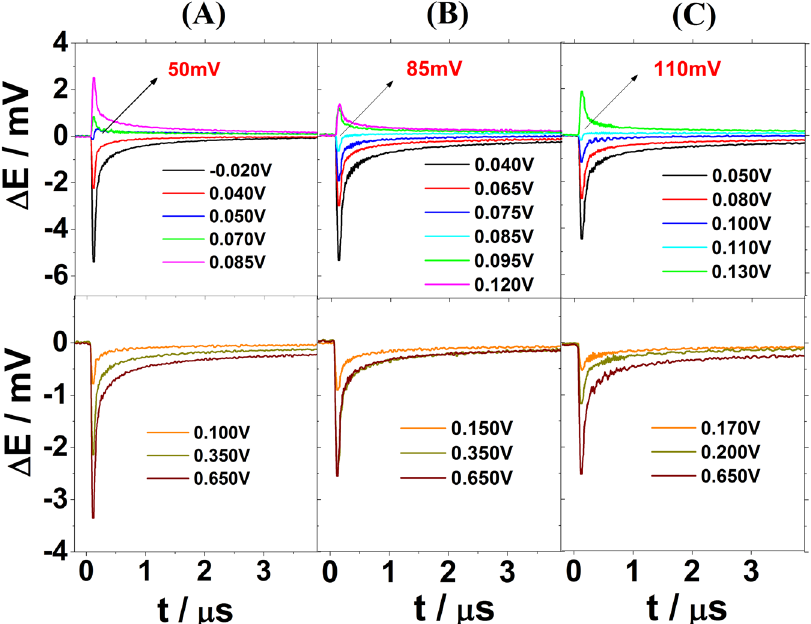
Figure 7. Laser induced potential transients for Ir(111) electrodes in contact with ( A ) 0.1 M H 2 SO 4 , ( B ) 0.01 M